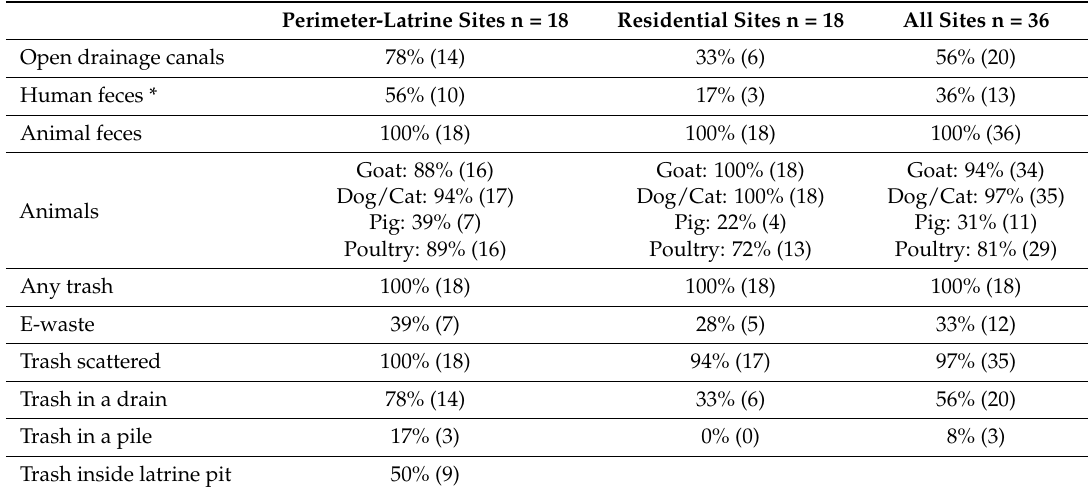
Table 2. Proportion of observation sites with environmental conditions